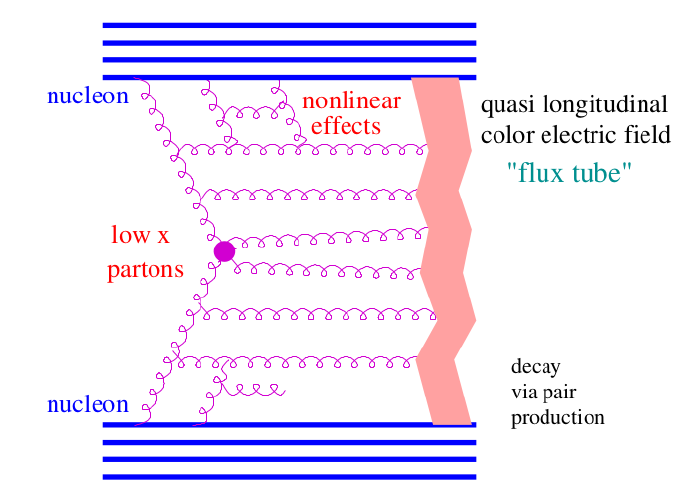
Figure 1. Elementary interaction in the EPOS model